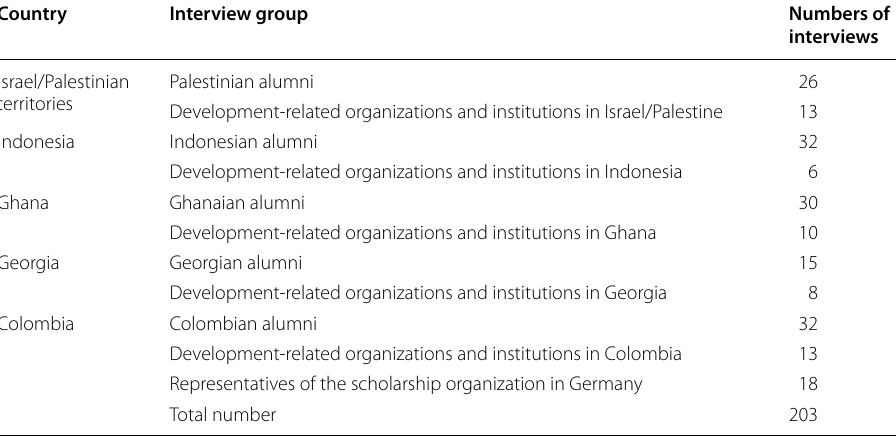
Source: table created by the authors